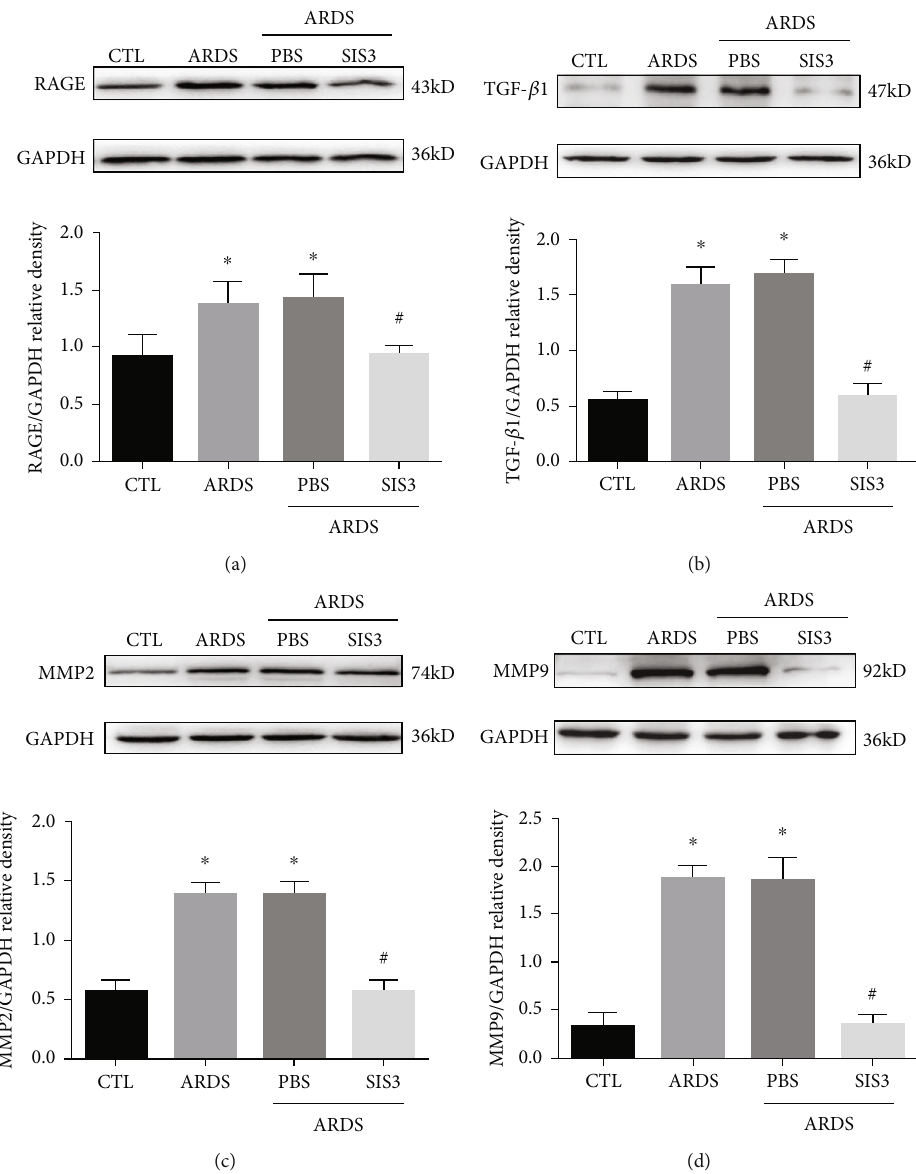
Figure 5: SIS3 inhibited the protein expression of RAGE, TGF- β 1, MMP2, and MMP9 proteins in lung homogenates acquired from ARDS rats. The expression levels of RAGE, TGF- β 1, MMP2, and MMP9 proteins in lung tissue homogenates, sera, and BALF of ARDS rats and were determined using western blotting analysis at 24 h after LPS intervention. The results of western blotting showed that SIS3 inhibited LPS- induced (a) RAGE, (b) TGF- β 1, (c) MMP2, and (d) and MMP9 protein expression in the lung homogenates. The data are presented as the means ± SD ( n = 10 ). ★ P < 0 : 05 vs. CTL; # P < 0 : 05 vs.